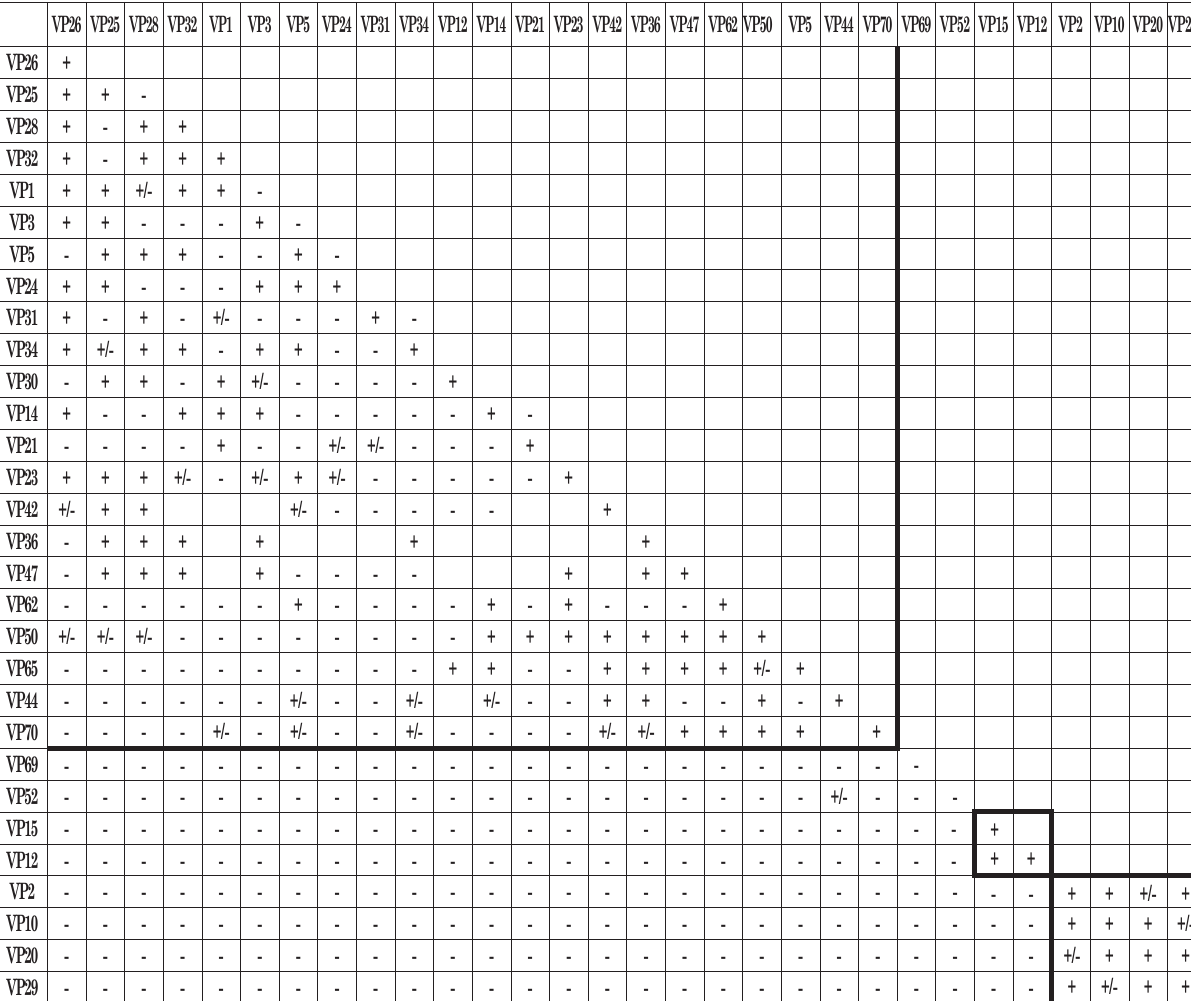
Table 1. Vegetative compatibility grouping of a collection of 30 Verticillium dahliae isolates from pistachio a